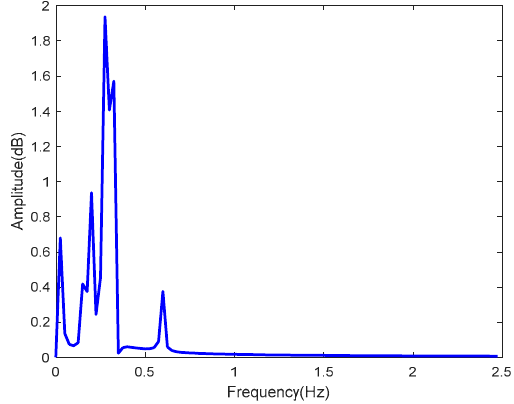
Figure 51. Spectrum of random sinusoidal displacement. Figure 52. Spectrum of random sinusoidal